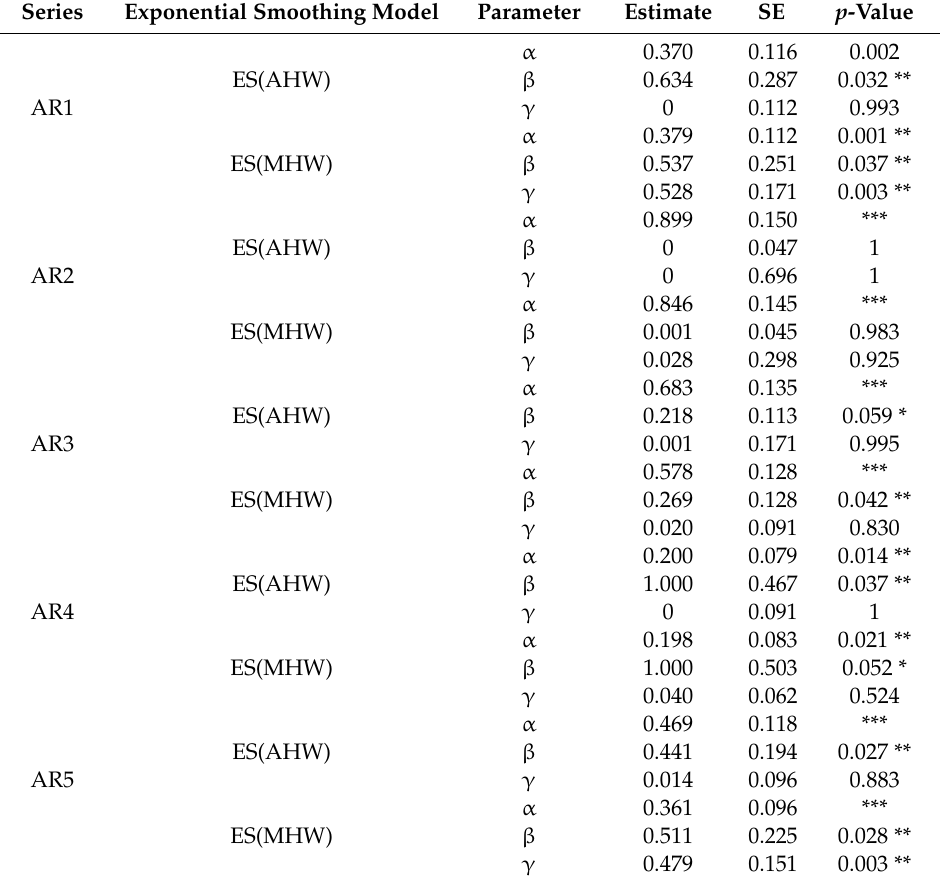
Table 2. Estimated parameter values with significant test for exponential smoothing